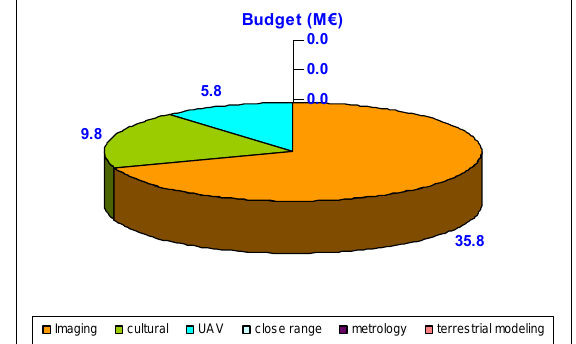
Figure 4. EU FP7 funded Projects In Fig. 5 we present an interesting “mapping” of the internal structure of the network of the funded projects. The big circles show the checked categories “Imaging”, “UAV” and “Cultural Heritage”). The small circles represent the acronym of the funded project and the origin country of the coordinator. The lines represent the different partners for each project, while the color represents the FP7 program, within which the project has been funded.